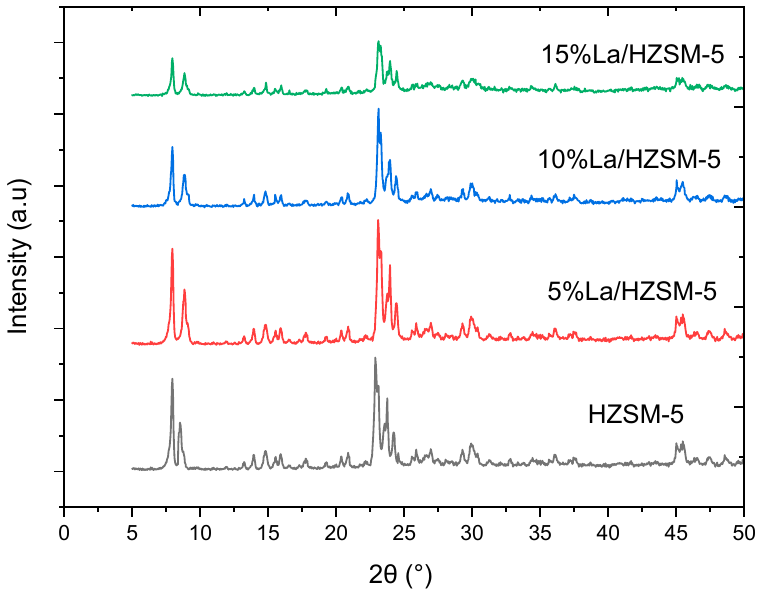
Figure 4. XRD patterns for parent HZSM-5 and lanthanum-modified zeolite catalysts. The XRD patterns of 5%La/HZSM-5, 10%La/HZSM-5, and 15%La/HZSM-5 are sim- ilar to those of the parent HZSM-5 in the peak positions and shapes, which also indicates that the lanthanum-modified HZSM-5 zeolites have a typical MFI (Mobil fifth) structure [52]. As a consequence, no impurity peaks were found based on the XRD data, and crys- talline phases of lanthanum oxides are not detected in the XRD patterns, which indicates